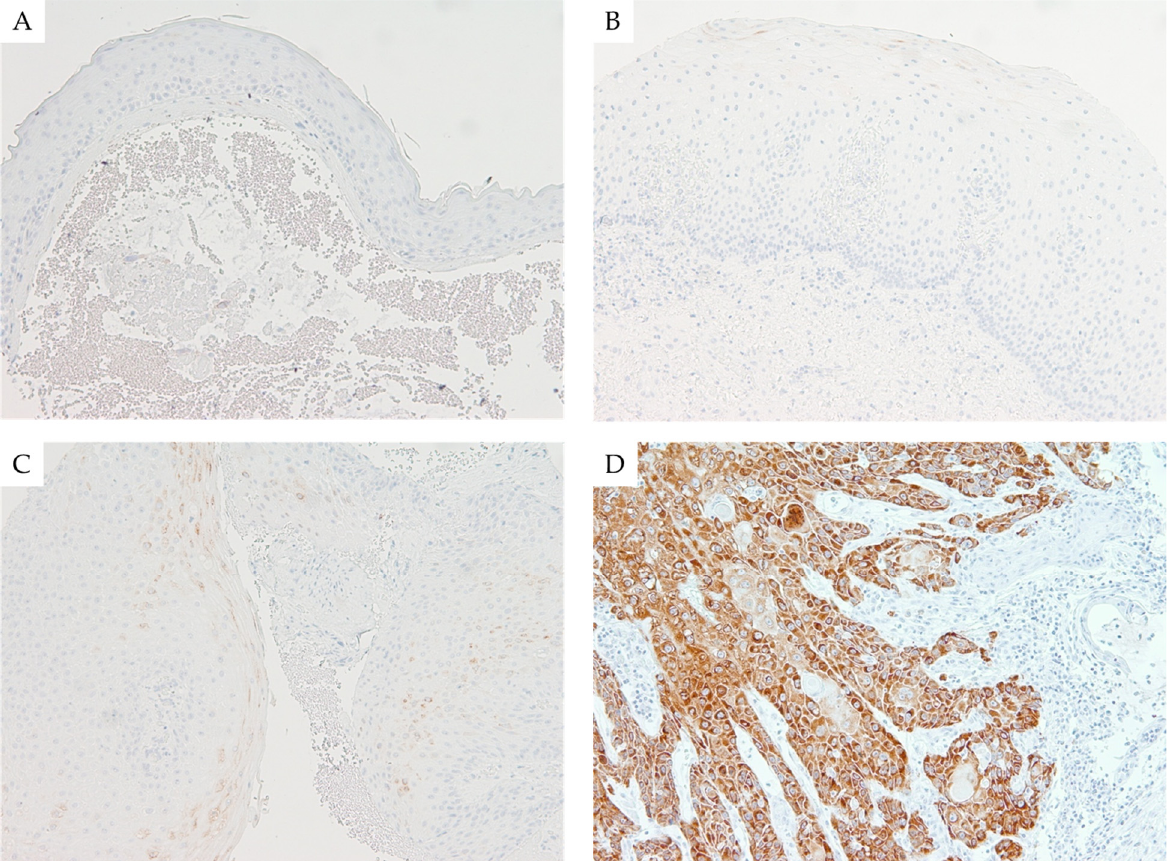
Figure 2. Immunohistochemical expression of IMP3 in laryngeal lesions: Comparison of focal and weak immunohisto- chemical cytoplasmic staining against IMP3 in laryngeal nodule ( A ), low-grade dysplasia ( B ), and high-grade dysplasia ( C ) versus diffuse and strong cytoplasmic staining in laryngeal squamous cell carcinoma (LSCC) ( D ); (100× magnification). Table 2. Comparison of mean values of Ki-67, p53, cyclin D1, and IMP3 protein expression in laryngeal lesions.